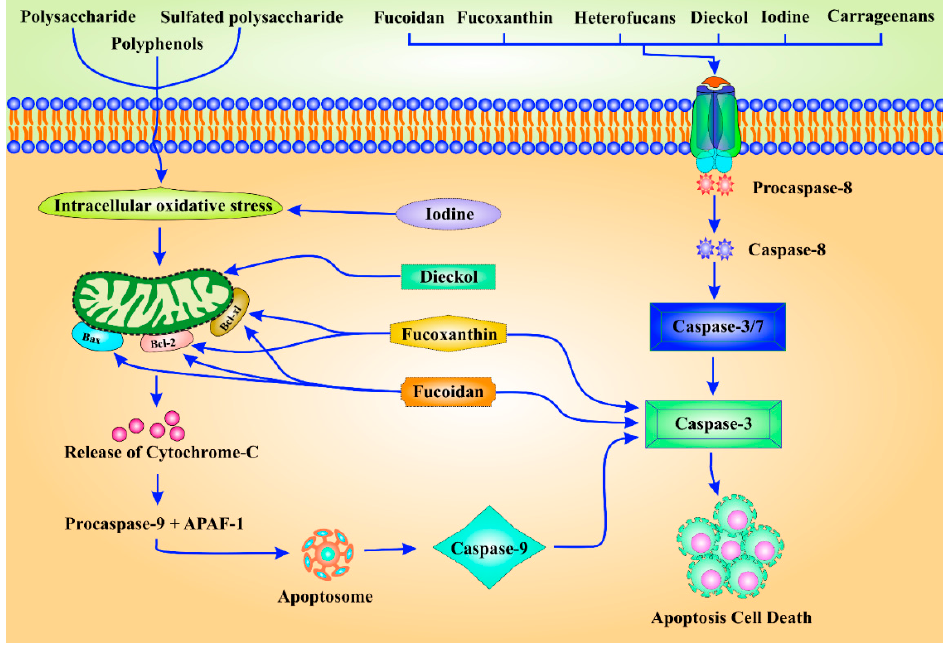
Figure 4. Apoptosis modulation by algal metabolites in cancer prevention. Polysaccharides, sulfated polysaccharides, io- dine, dieckol, fucoxanthine, fucoidan, and polyphenols downregulate the expression of anti-apoptotic protein Bcl-xl, Bcl- 2. Similarly, they enhance the Bax expression to aid apoptosis. Fucoidan supports the intrinsic apoptosis via regulating the cytosolic release of cytochrome C. Fucoxanthine and fucoidan induces the expression of caspase 9 and caspase 3 to induce apoptotic cell death. Moreover, fucoidan, fucoxanthine, heterofucans, dieckol, iodine, and carrageenans induce apoptosis through modulation of caspase 3 activity via death receptor-mediated apoptotic cell death in several cancer cell lines. In addition to this, they also regulate caspase 8 activity inducing extrinsic apoptosis in different cancer cells.